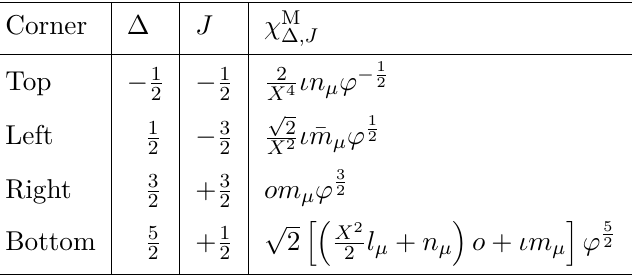
Table 15. Elements of the celestial diamond corresponding to a supergravity memory effect.